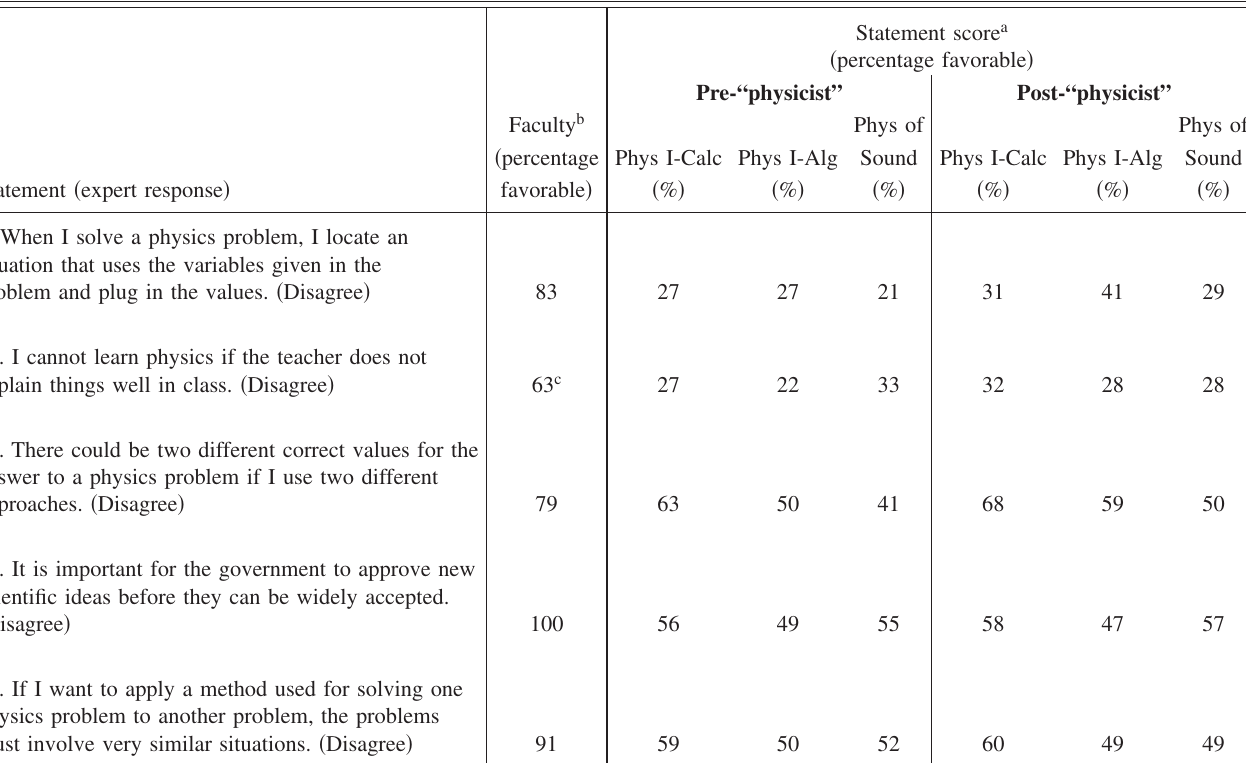
TABLE II. Statements with the most novicelike “physicist”